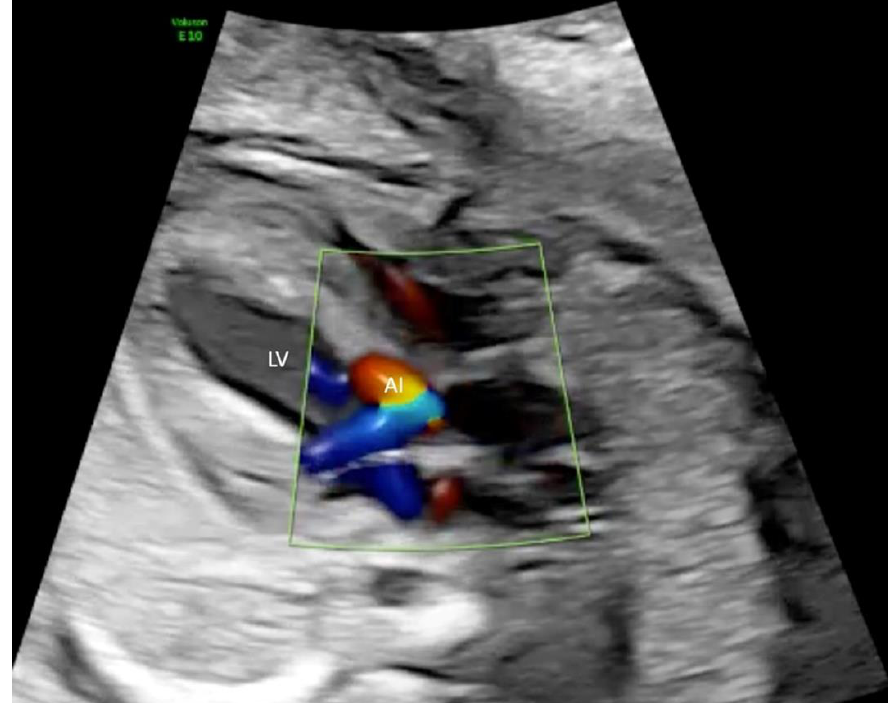
Figure 5. Left outflow tract view in a fetus at 27 + 0 weeks of gestation with severe aortic stenosis after successful balloon dilatation of the aortic valve. Color Doppler demonstrates aortic insufficiency (AI) in diastole. LV, left ventricle.